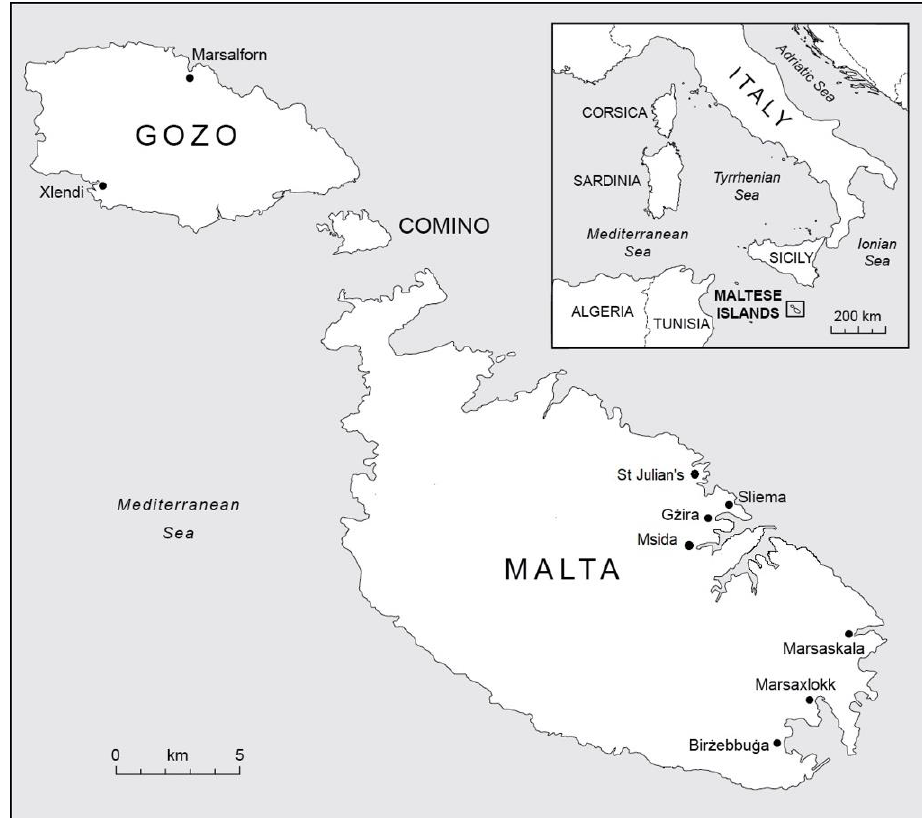
Figure 1. Location of five selected sites of coastal towns: Gżira, Sliema and St Julian's (Malta) and Marsalforn and Xlendi (Gozo). Marsaskala, Marsaxlokk, Birzebbuġa and Msida were selected in a previous (2019) study by same authors.